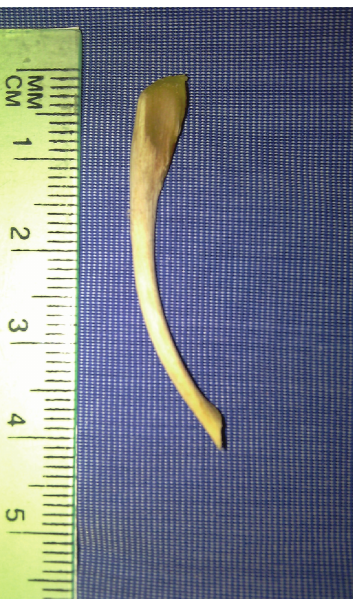
Figure 2: The chicken bone which was almost 4-cm-long after being successfully removed from the